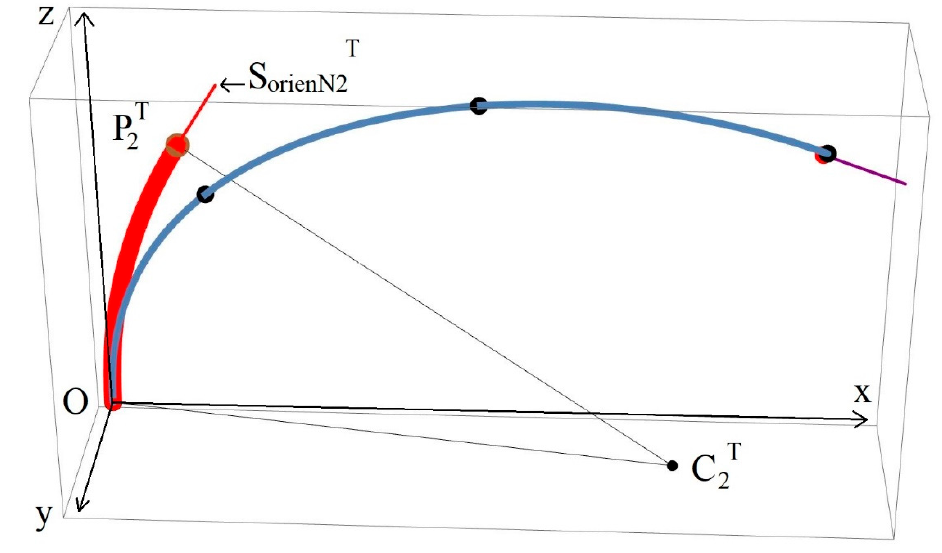
Figure 12. Second segment endpoint P 2T and orientation vector s orienN2T in the first segment’s coordinate system.